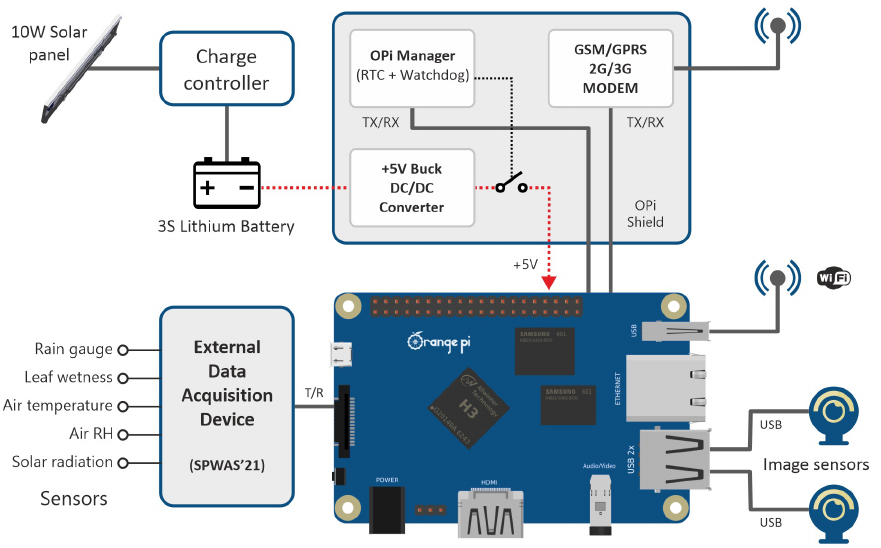
Figure 1. VineInspector’s hardware setup